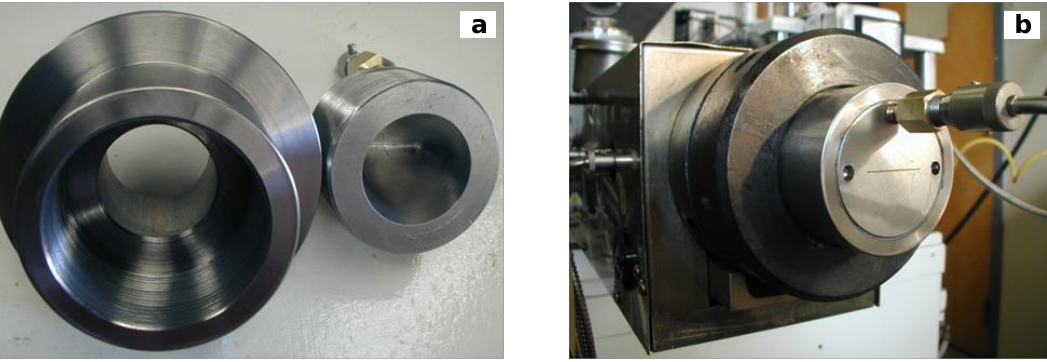
Figure 5. A slit die for film extrusion: ( a ) die components; ( b ) die assembly.